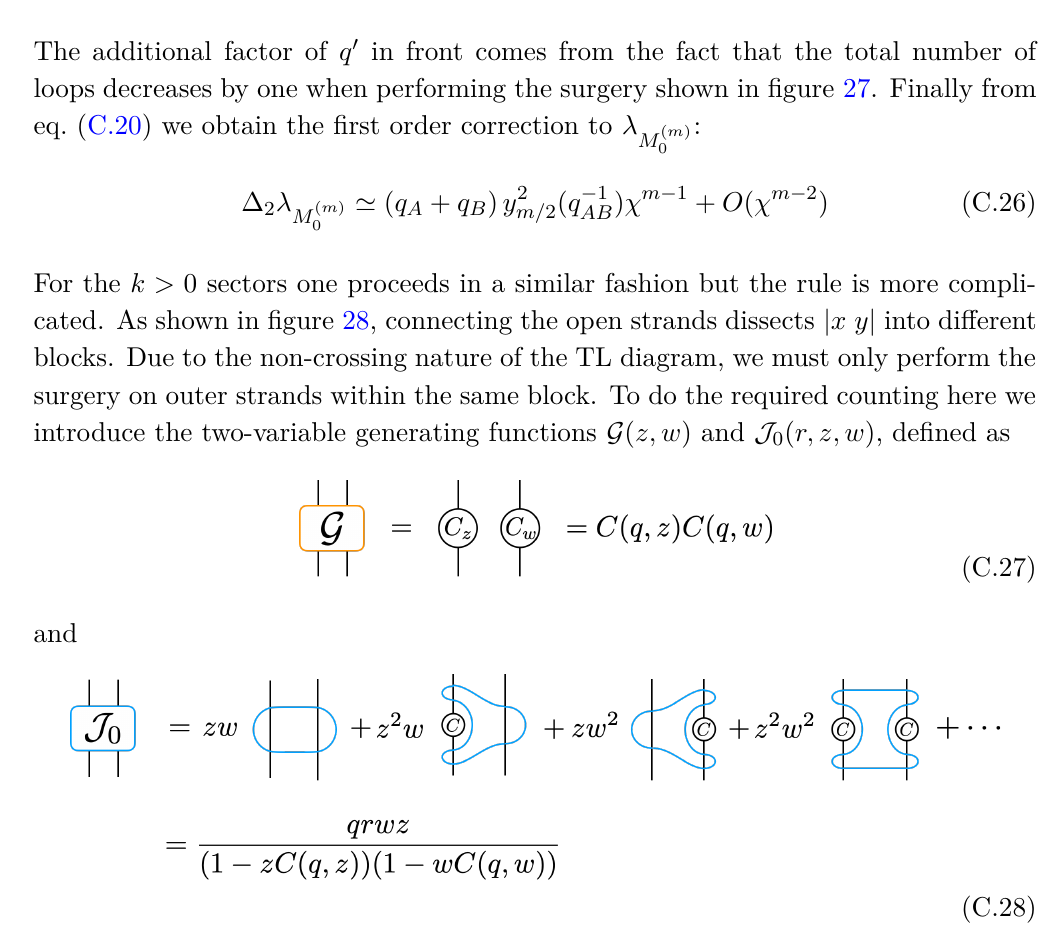
Figure 28 . The procedure of constructing leading diagrams for h x | D ( h ) | y i for the k > 0 sector. Starting with the diagram | x y | , a similar procedure of cutting and gluing two outer strands are performed. However different to the k = 0 case, the two outer strands being cut must stay inside the same block. This is demonstrated using scissors with the same color in the above figure: the surgery on | x y | can be performed either on the strands with two black scissors (which produces the first diagram on r.h.s. ), or strands with two red scissors (which produces the second diagram on r.h.s. ), but performing surgery on a black-red scissor pair is